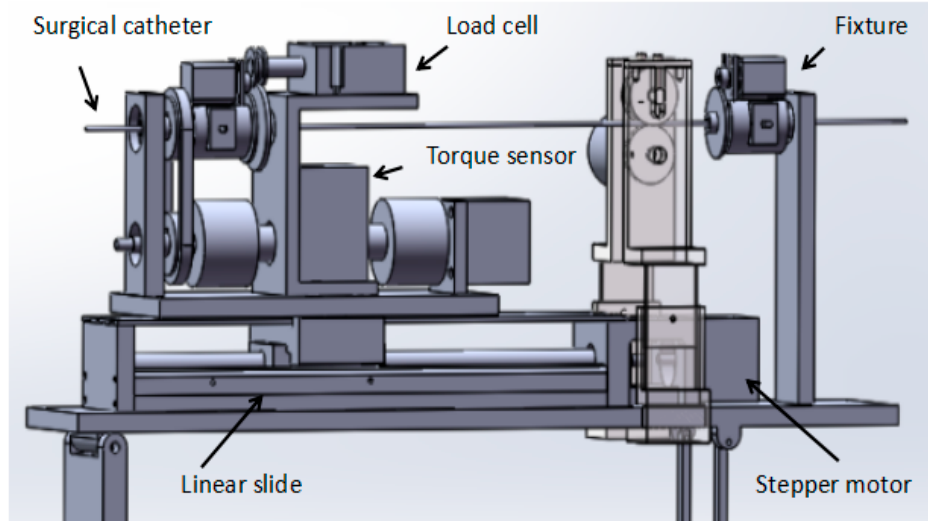
Figure 3. The novel structure of the slave manipulator.